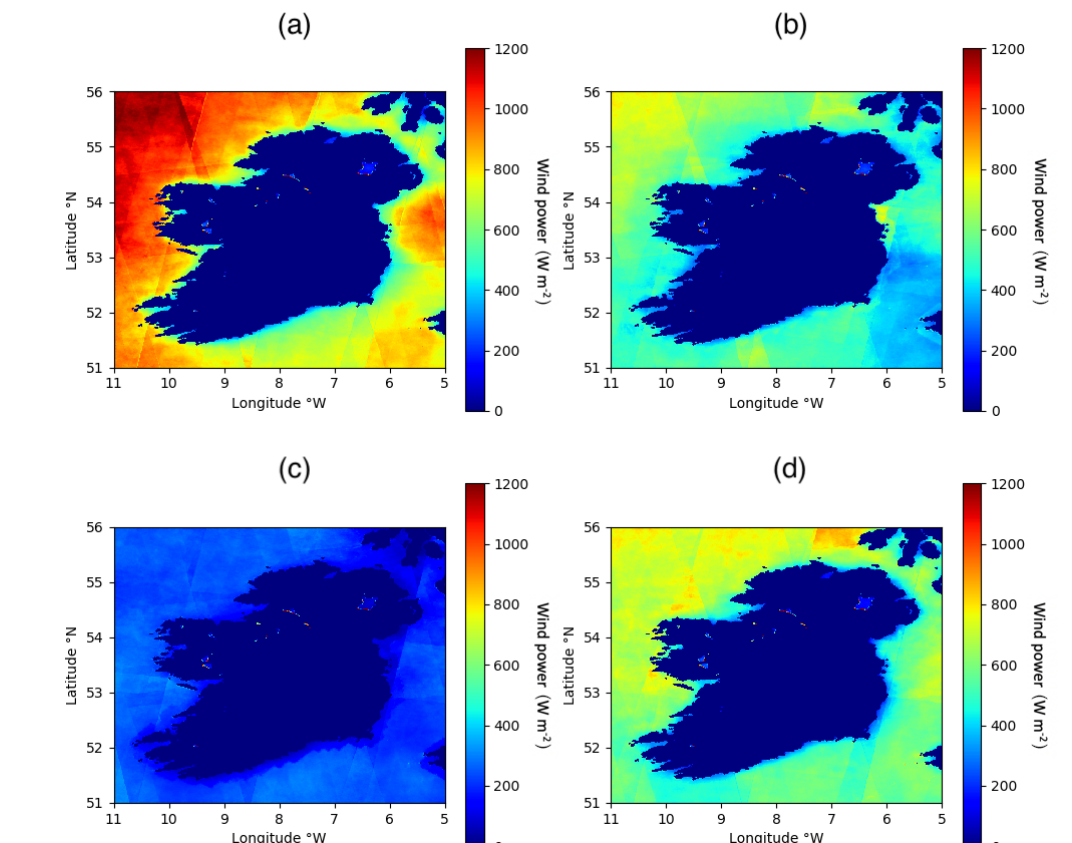
Figure 10. Seasonal wind power off Ireland over a 2-year period running from May 2017 to May 2019 retrieved using the Sentinel-1 SAR Level 2 OCN product: winter (a) , spring (b) , summer (c) and autumn (d) . Satellite tracks are visible, particularly in the northeast. These are an artefact of the